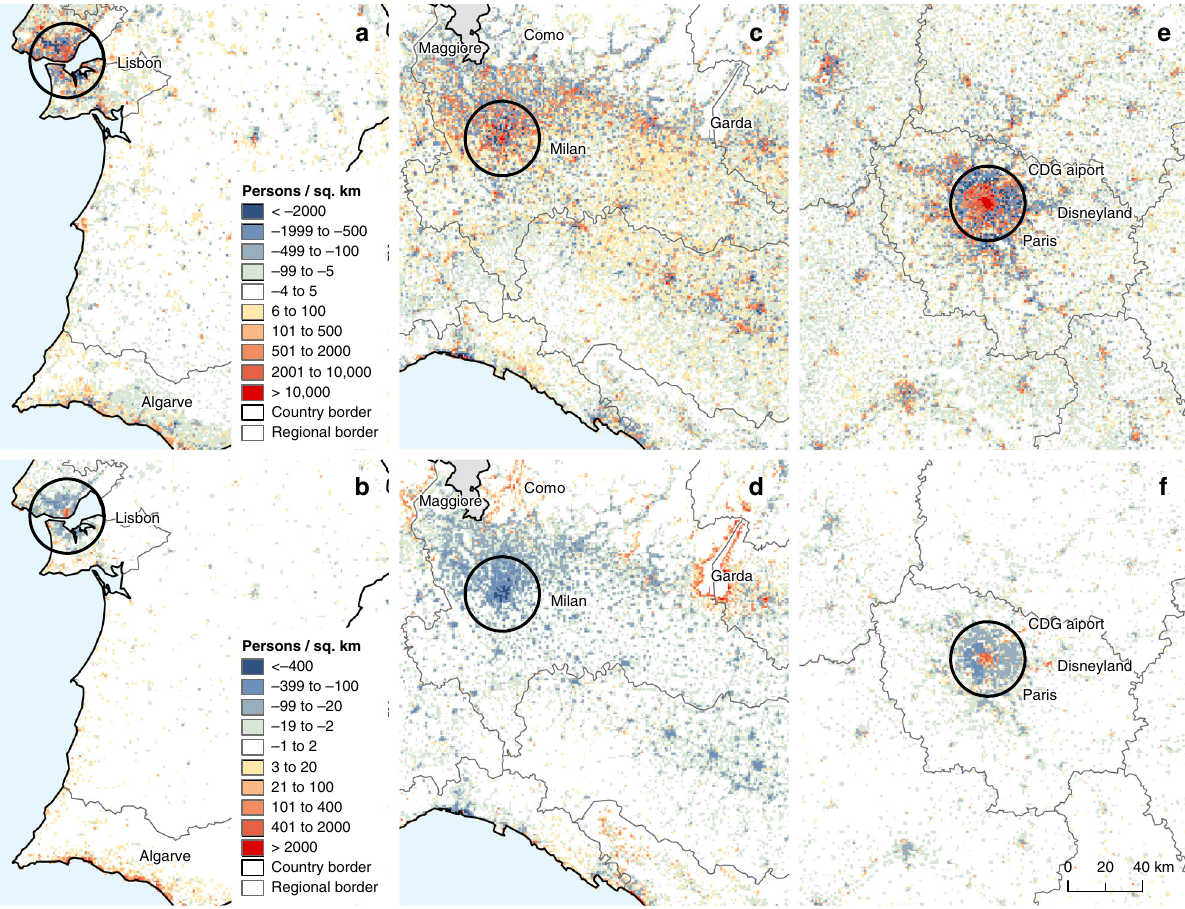
Fig. 2 Spatio-temporal differences in population density in selected sites. Absolute differences in population at 1 km 2 grid-cell level between day- and nighttime (average of all months) ( a , c , e ) and between August and January (at nighttime) ( b , d , f ) for south of Portugal ( a , b ), North of Italy ( c , d ) and Ile- de-France ( e , f ). The circles represent a radius of 20 km from the city centers of Lisbon, Milan, and Paris. The fi gure can be reproduced using the publicly deposited multi-temporal population grids 75 . Copyright EuroGeographics for the administrative boundaries.